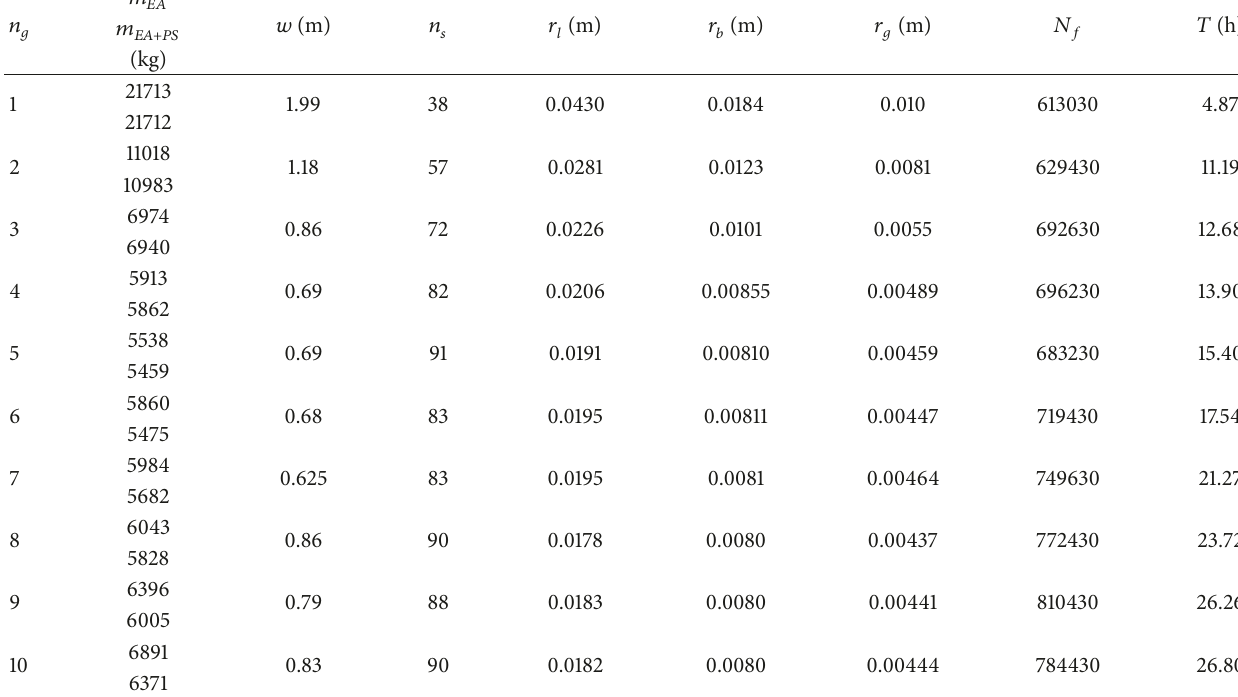
Table 2: Optimal mast parameters at 1–10 guys’